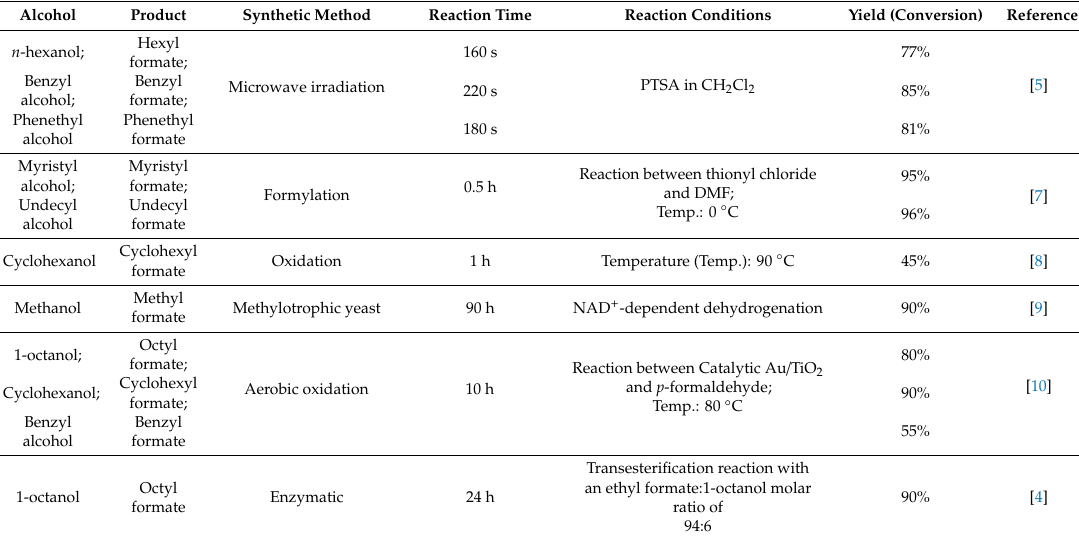
Table 1. Methods used for the synthesis of formate